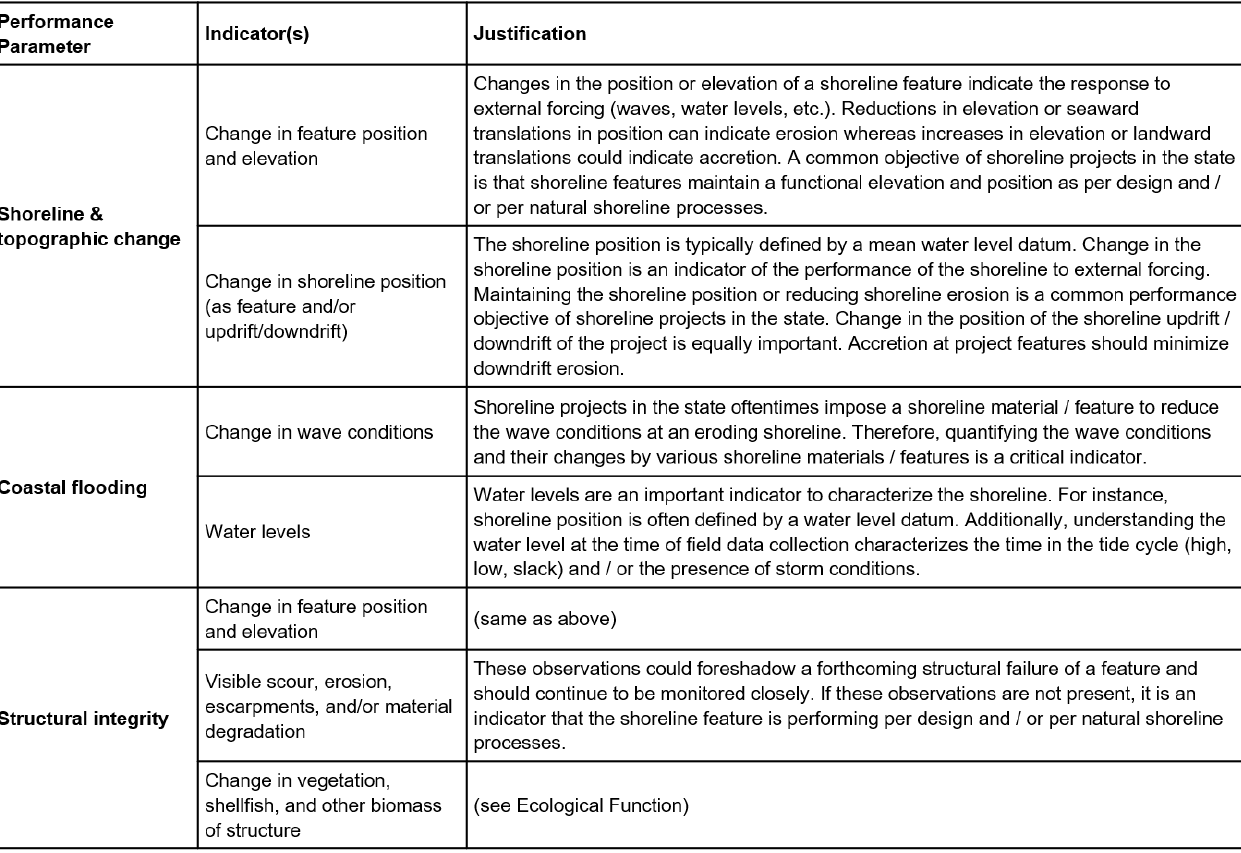
Fig. 8 . Field-tested performance parameters and indicators for structural integrity and hazard